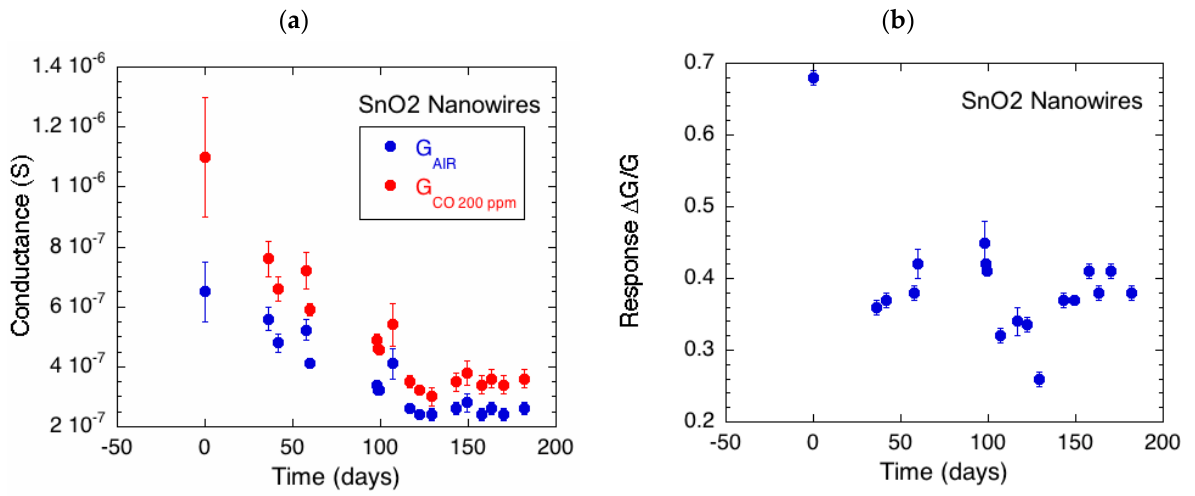
Figure 2. ( a ) Long-term drift in the conductance of SnO 2 nanowire gas sensors exposed to CO (red) and humidified synthetic air (blue); ( b ) relative change in the CO response upon long-term operation.